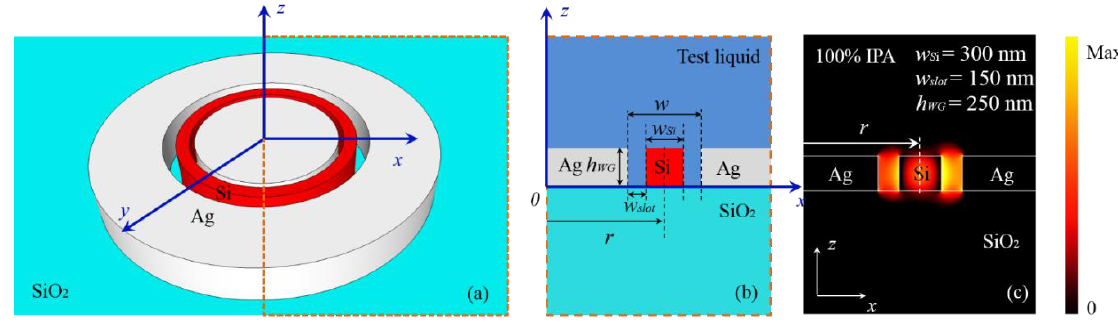
Figure 1. ( a ) Schematic of a double-slot hybrid plasmonic ring resonator; ( b ) x-z plane cross-section view; ( c ) power distribution of the x-z plane cross-section simulated by the axisymmetric finite element method. IPA,